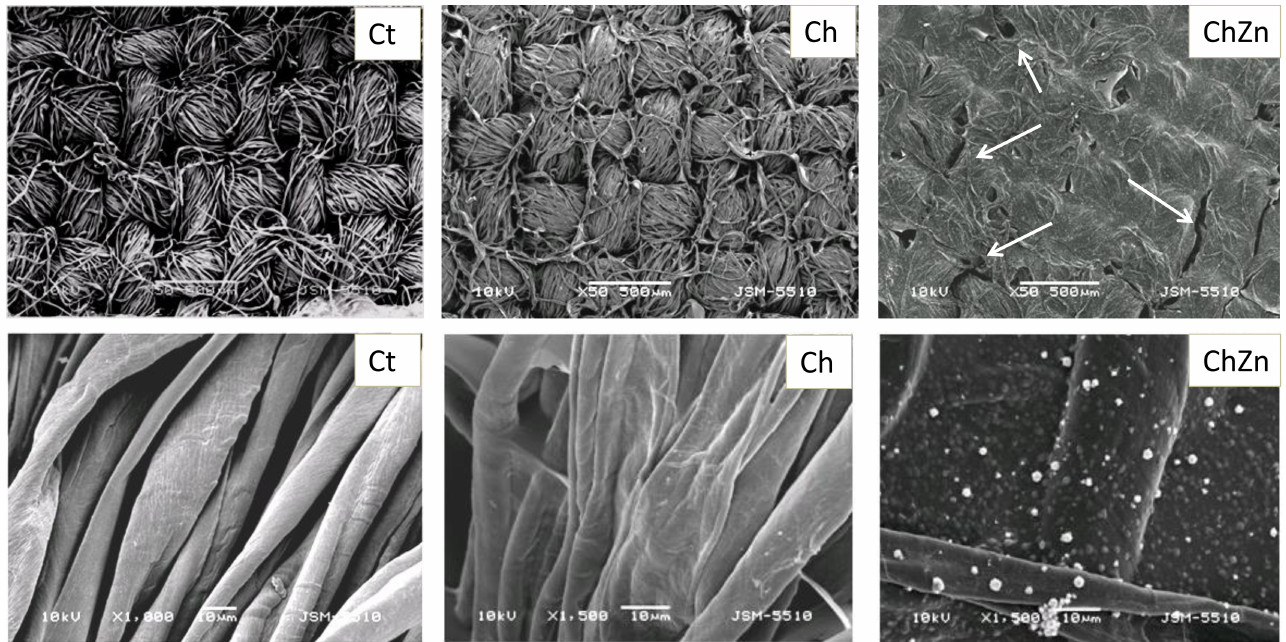
Figure 3. SEM images of the surface of a cotton fabric Ct and fabrics treated with Ch and ChZn at different magnifications ( × 50 and × 1500).